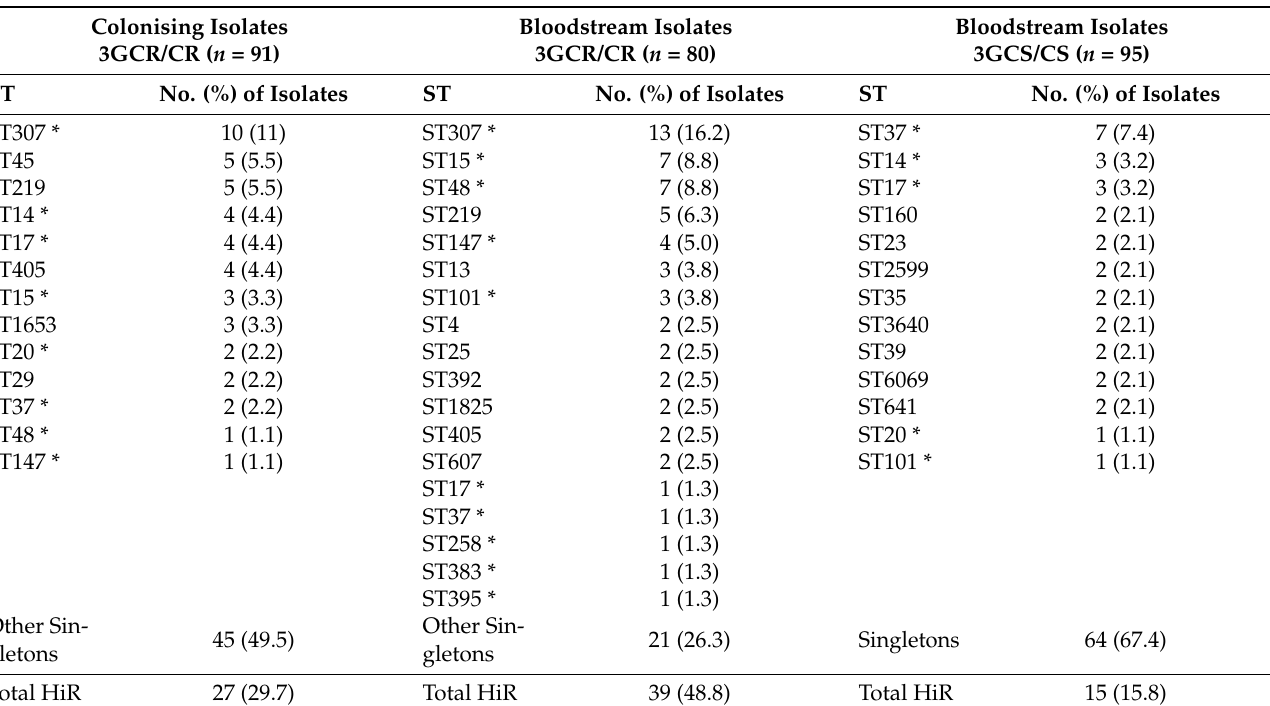
Table 2. Overview of the most frequent sequence types of colonising and bloodstream K. pneumoniae complex isolates excluding most